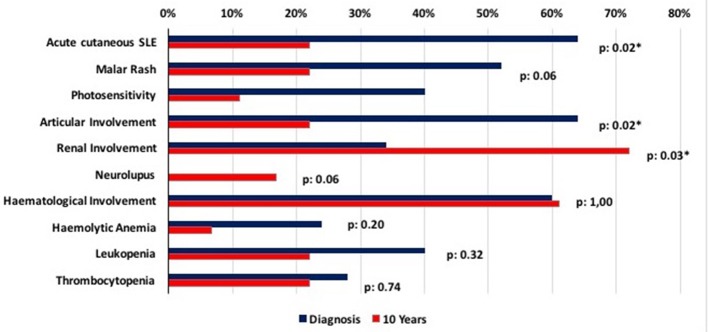
Differences in clinical profile at diagnosis and after 10 years of follow-up. Clinical data collected at diagnosis and after 10 years of follow-up are compared, highlighting the statistically significant reduction of articular and cutaneous involvement and the growth in the percentage of patients with renal involvement.